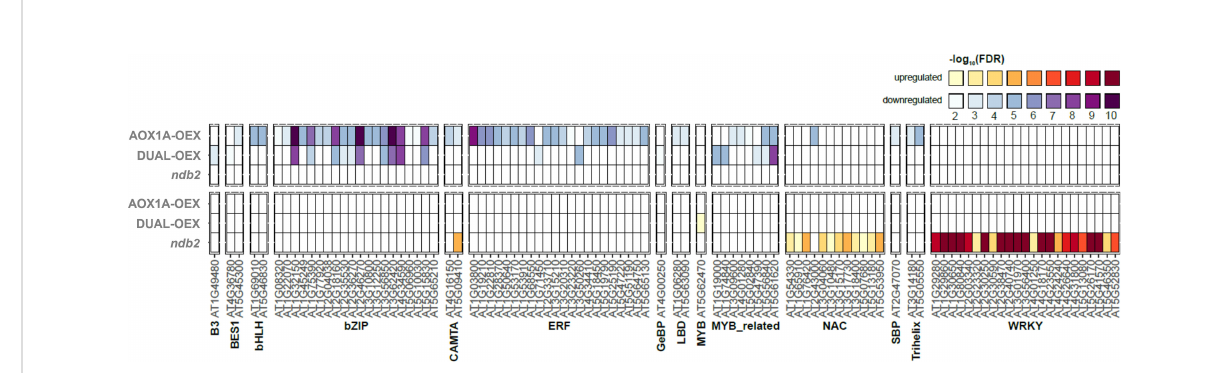
FIGURE 6 Enrichment of transcription factors based on differential expression of target genes. EAT-UpTF was used to pro fi le the enrichment of transcription factor target genes among the DEGs of each line, relative to wild type. greater colour intensity represents greater signi fi cance (-log 10 FDR). Transcription factors were enriched in both down-regulated (top) and up-regulated (bottom)